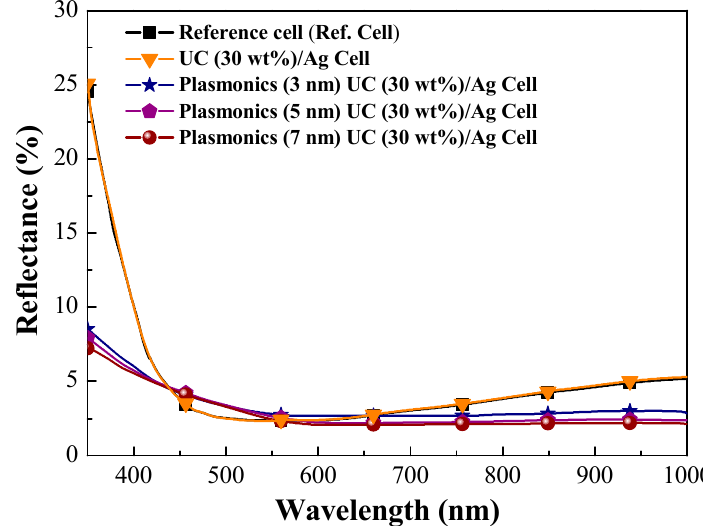
Figure 13. Optical reflectance of the reference cell, UC (30 wt%) / Ag cell and plasmonic UC (30 wt%) / Ag cell with In NPs (3 nm, 5 nm, 7 nm).